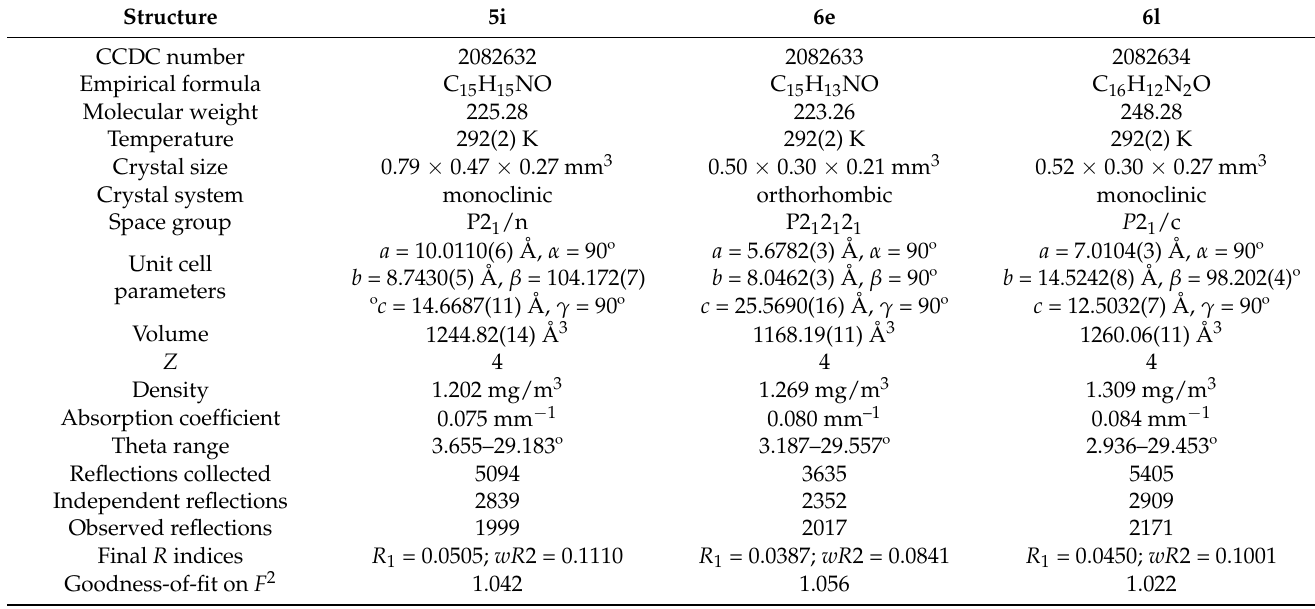
Table 4. Crystal data and structure refinement for 5i, 6e, and 6l